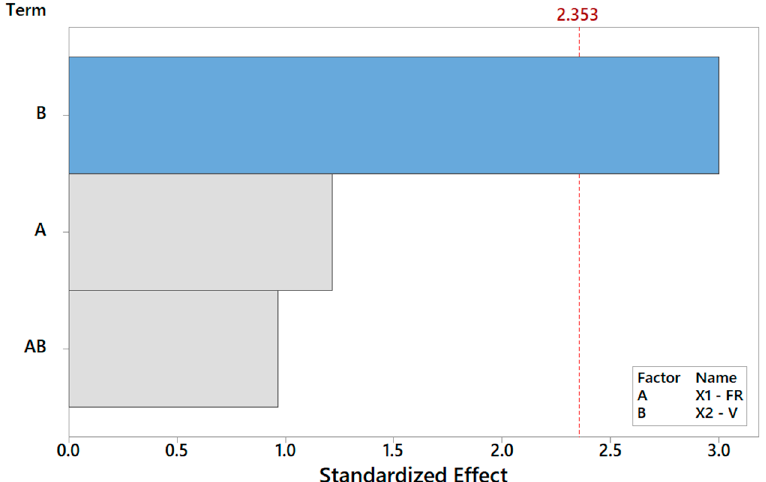
Figure 11. Pareto plot of standardized effects for Y 6 from Table 8, rendering a visual ranking of their role on cell adhesion. A gray bar represents a term not in the model.